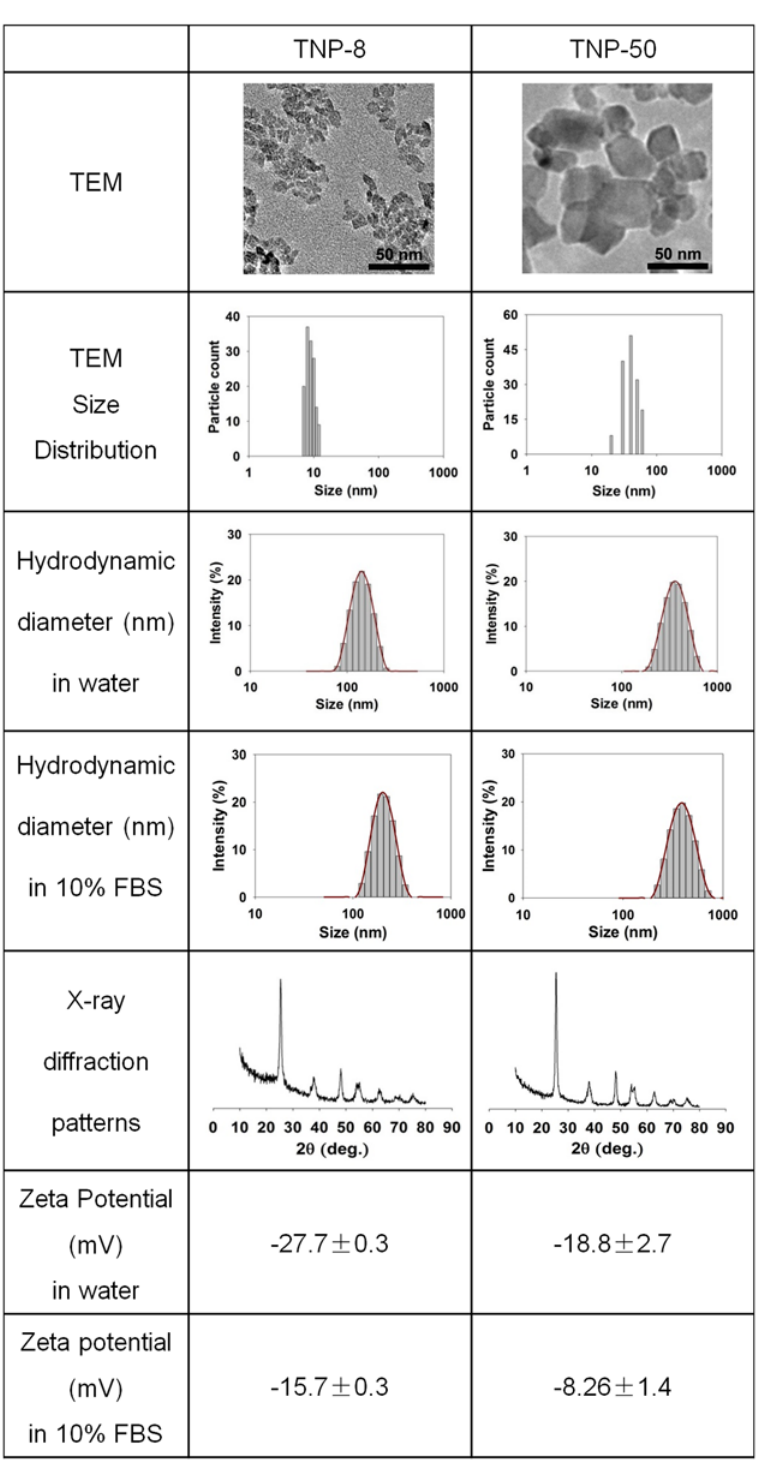
Fig 1. Characterization of TNPs.